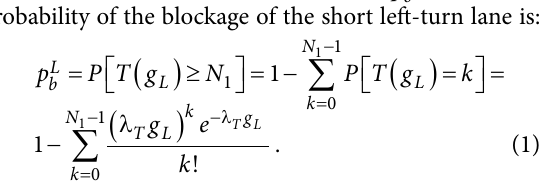
Fig. 2. Blockage and overflow of short left-turn lane under lagging left-turn phasing: a – signal phase sequence; b – overflow of short left-turn lane during the green phase for the through movement and red phase for the left-turn movement; c – blockage of short left-turn lane during the green phase for the left-turn movement and red phase for the through movement; d – blockage of short left-turn lane during the red phase for both left-turn and through movements; e – overflow of short left-turn lane during the red phase for both left-turn and through movements 1.1. Leading Left-Turn Phasing During the green phase for the left-turn movement and red phase for the through movement, the probability of p the overflow of the short left-turn lane is = 0 L o